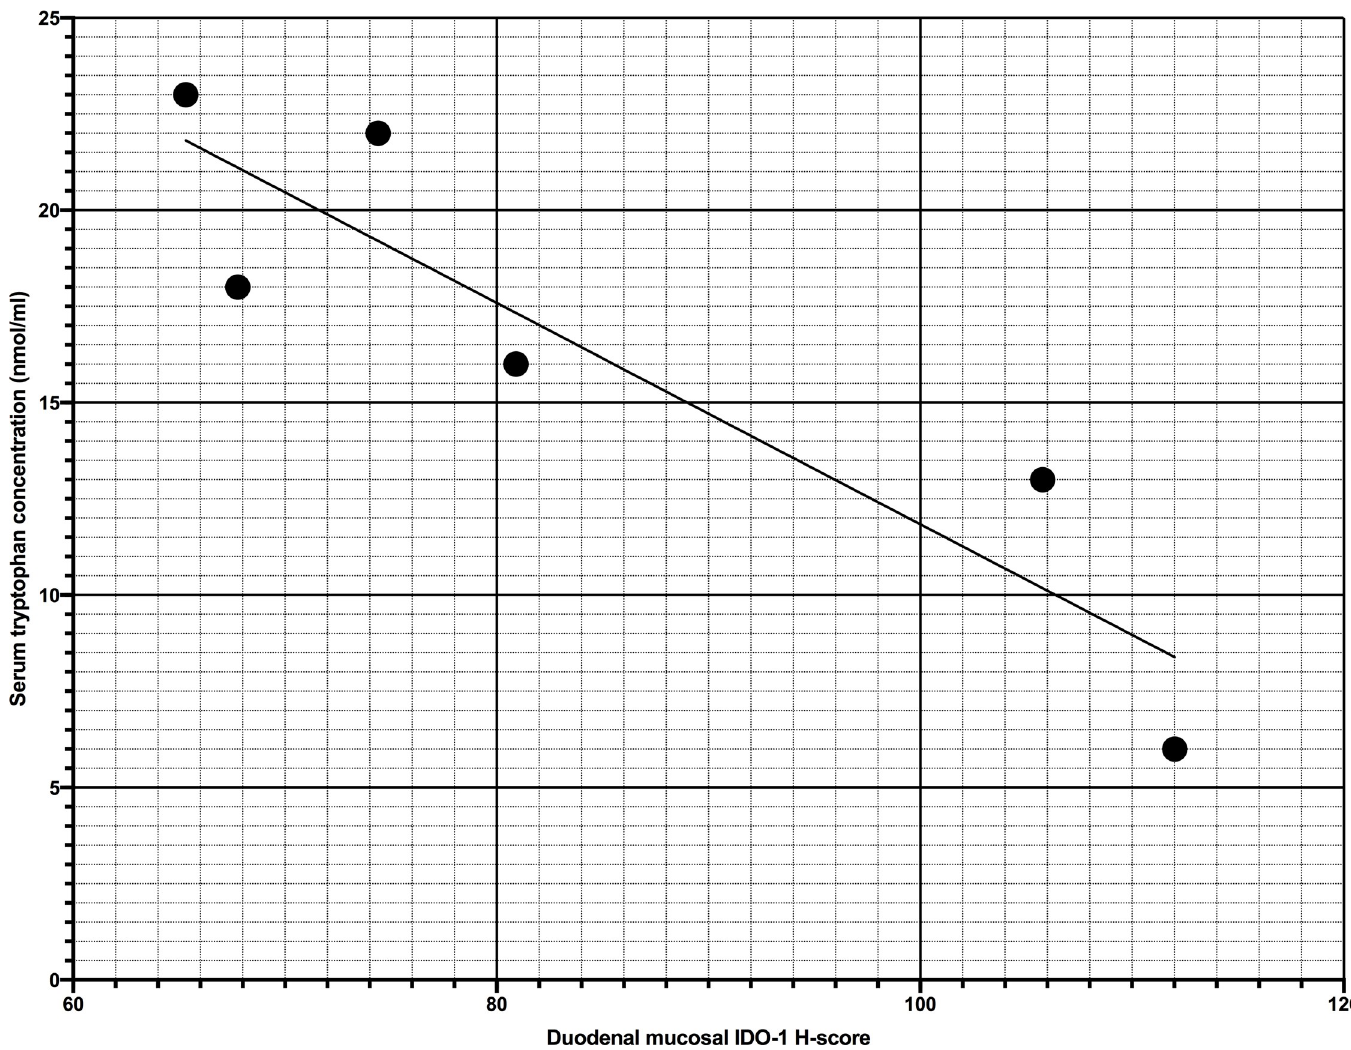
Fig 5. Scatter plot of serum tryptophan concentrations and duodenal mucosal IDO-1 H-score in dogs with protein-losing enteropathy. Scatter plot of serum tryptophan concentrations (nmol/ml) and duodenal mucosal IDO-1 H-score of 6 dogs with protein-losing enteropathy (PLE). Serum tryptophan concentrations were significantly negatively correlated with mucosal IDO-1 H-score in dogs with PLE (Spearman’s rank correlation co-efficient: -0.94, P = 0.0048).